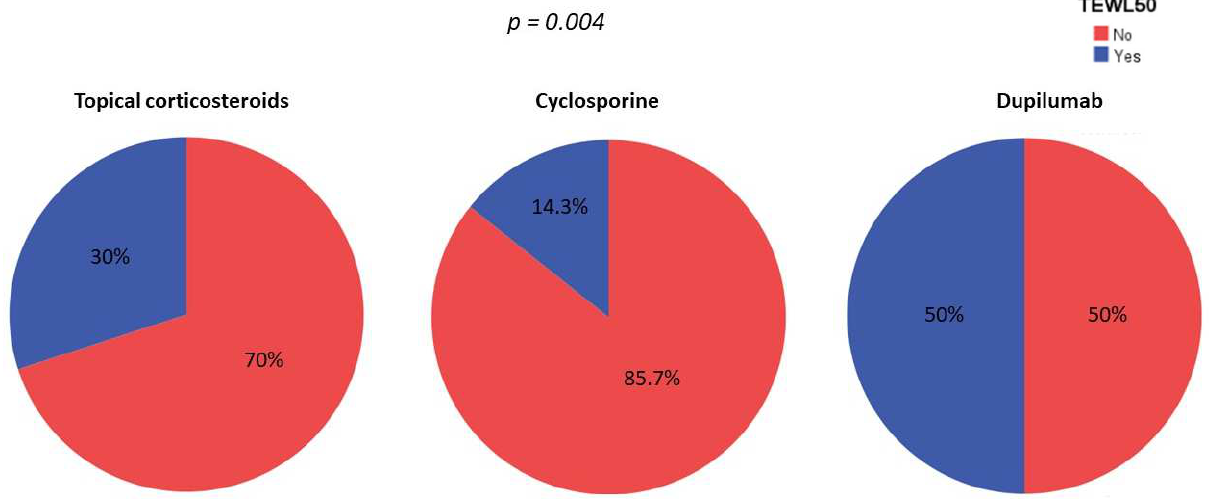
Figure 3. Percentage of patients reaching TEWL-50 by treatment. p -value after conducting a multi- variable logistic regression model adjusted by age, age of disease onset, sex, smoking habit and skin hydration habit